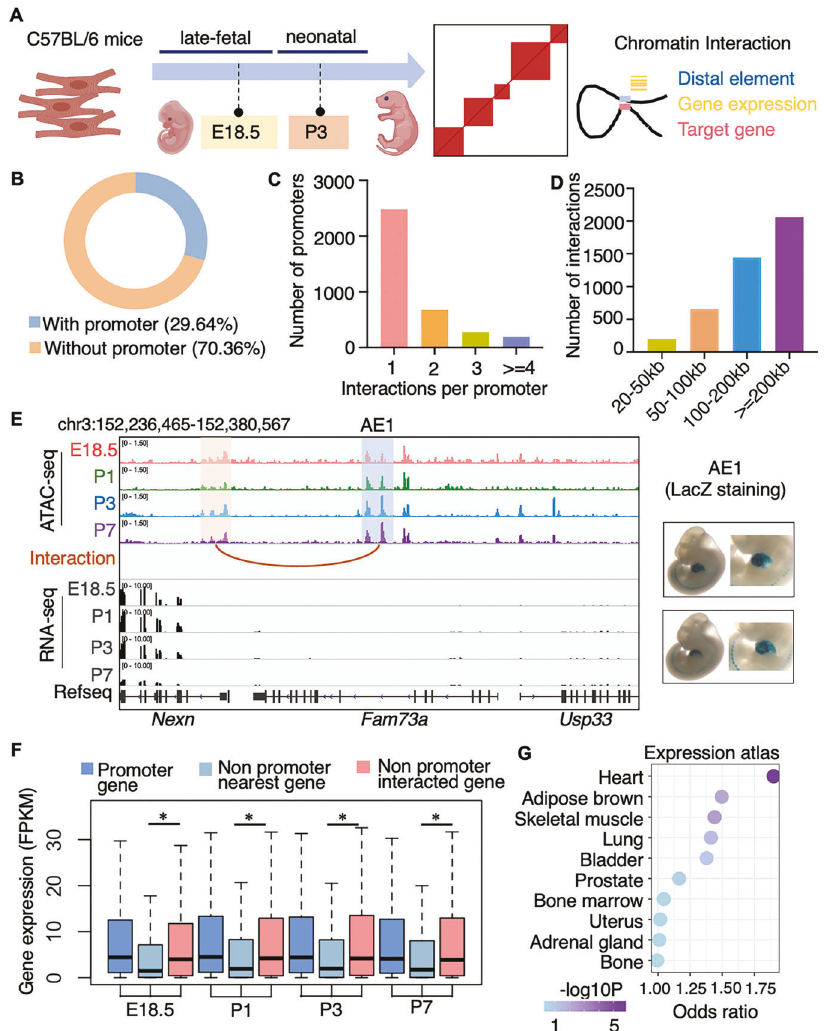
Fig. 3 Transcriptional regulation network captured by chromatin interactions in cardiomyocytes. A Experimental strategy to capture chromatin interactions in perinatal cardiomyocytes. B Proportion of the interaction types. C Histogram of promoters with different numbers of interactions in HiChIP promoter-involving interactions. D Histogram of promoter-involving interactions with different sizes. E Genome browser view at Nexn -AE1 locus with chromatin accessibility and chromatin interaction in cardiomyocytes. The AE1 and Nexn promoter are marked with blue and orange boxes, respectively. The interaction between AE1 and Nexn promoter is indicated by the brown arch (left). LacZ staining in mouse embryo from VISTA database reveals heart enhancer activity of AE1 (right). F Gene expression of promoter-associated genes and the nearest or the interacting genes of the same non-promoter regulatory element (center line, median; box limits, upper and lower quartiles, Wilcoxon rank sum test, P for non-promoter nearest gene vs. interacted gene expression in E18.5, P1, P3, and P7 are 2.2E-16, 1.484E- 14, 1.388E-14 and 2.511E-14, respectively. * indicates P < 0.05). G Top 10 tissues with enriched expression of target genes of the distal regulatory